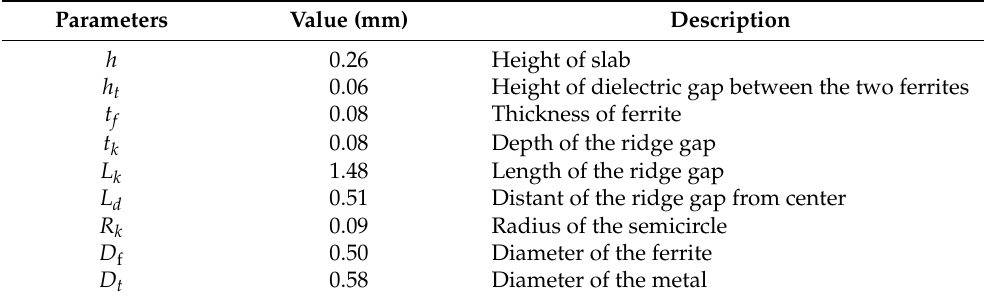
Table 1. Dimensions of the PC slab circulator.